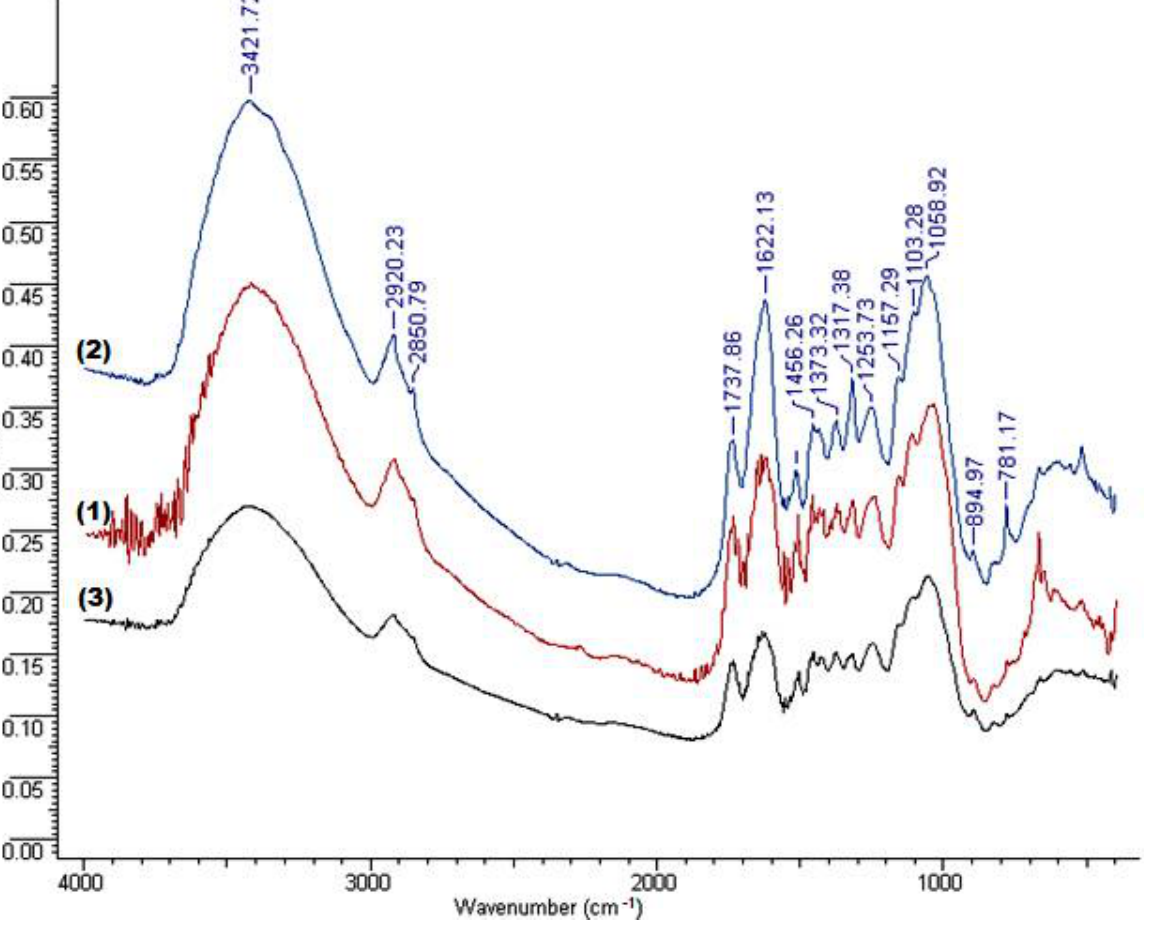
Figure 4. FTIR spectra: (1) plum, (2) apricot, and (3) peach.